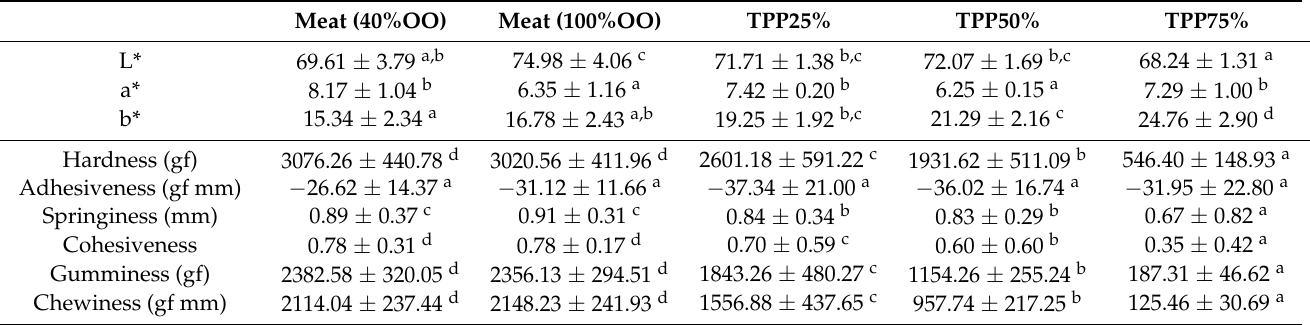
Table 4. Mean values (+SD) of color and texture parameters for all frankfurter